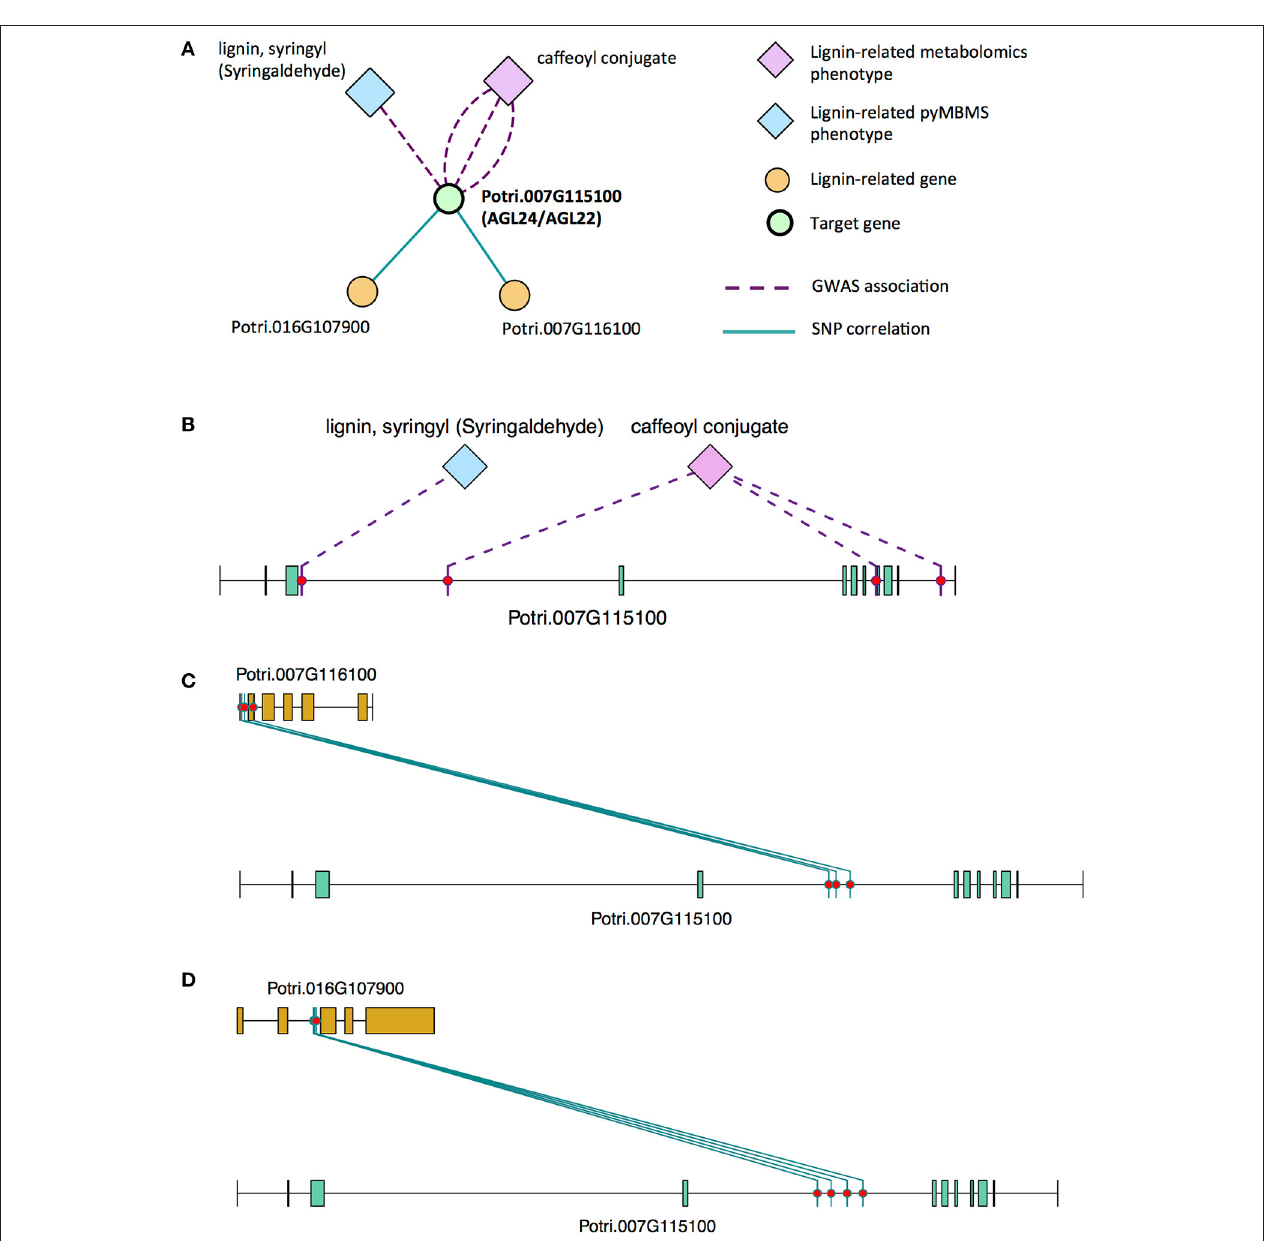
FIGURE 5 | (A) Lines of evidence for Potri.007G115100 ( homolog of Arabidopsis AGL22/24). (B) GWAS associations of Potri.007G115100 with a lignin-related metabolite and a lignin-related pyMBMS peak ( Table 1 ). (C,D) Correlations of SNPs in Potri.007G115100 with SNPs in two lignin-related genes ( Table 4 , Table S5).